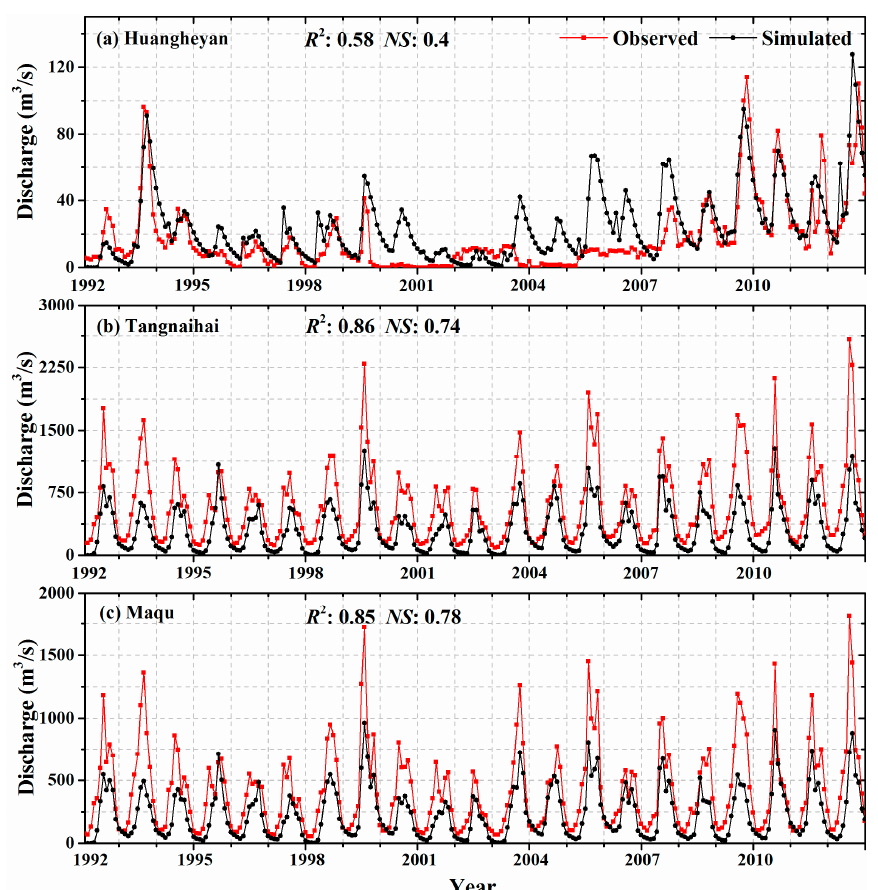
Figure 6. Monthly runoff simulation results compared to observations for the variation period (1992–2012) using the same calibrated parameter values and five elevation bands that were used to produce the calibration and validation results shown in Figure 5 and Table 4.